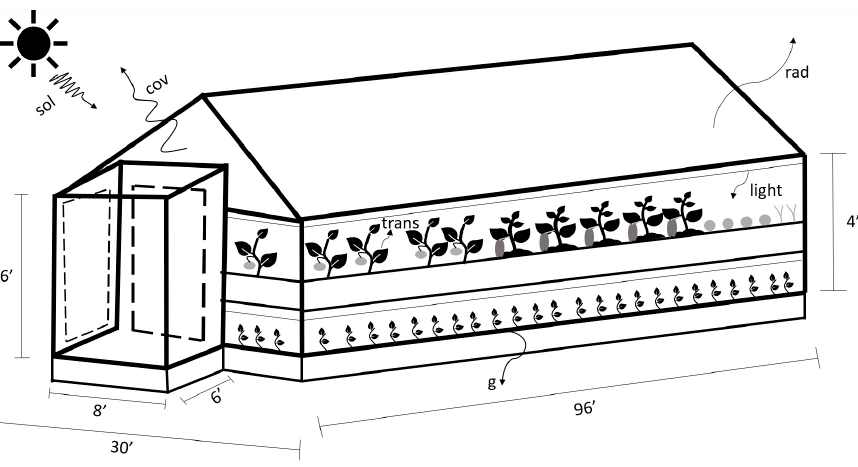
Figure 2. A schematic of the designed greenhouse. Figure 2 . A schematic of the designed greenhouse.